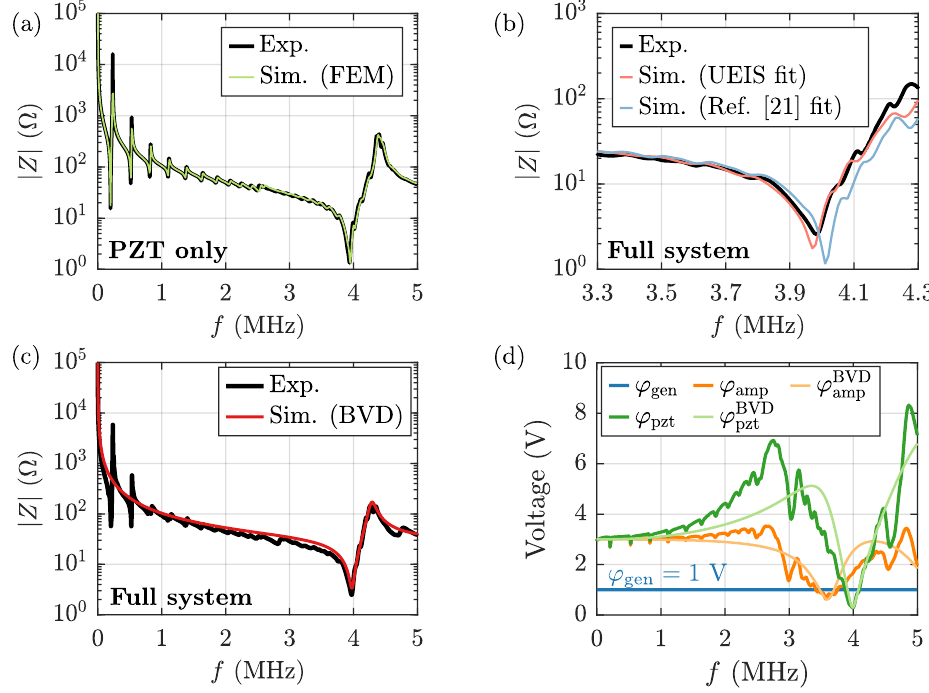
Figure 2. ( a ) Measured (black) and simulated (green) electrical impedance spectrum | Z ( f ) | in the frequency range 0.5–5000 kHz of the unloaded Pz27 disk. ( b ) Measured (black) and simulated | Z ( f ) | for 3.3–4.3 MHz, using either UEIS fitted parameters (red) or the parameters from Ref. [21] (blue) of the full system consisting of Pz27 disk, glue layer and liquid-filled glass capillary tube. ( c ) The measured | Z ( f ) | (black) for 0.5–5000 kHz of the full system (Pz27 disk, glue layer, and liquid-filled glass capillary tube), and the computed | Z ( f ) | (red) based on the single-frequency BVD-model of Section 2.4. ( d ) The three measured voltage amplitudes versus frequency f at different points in the circuit: ϕ pzt (dark-green) obtained by four-probe measurements directly across the piezoelectric transducer, ϕ amp (dark-orange) measured at the output of the amplifier, ϕ gen (dark-blue) measured at the signal generator. Shown also are the two LTspice -simulated voltage amplitudes: ϕ BVD pzt (light green) and ϕ BVD amp (light orange) computed from the